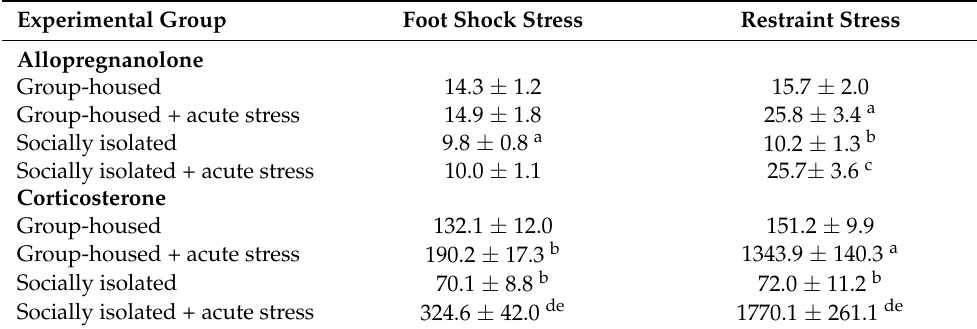
Table 1. Effect of physical and psychological acute stressors on plasma allopregnanolone and corticosterone levels in group-housed and socially isolated female rats. Experimental